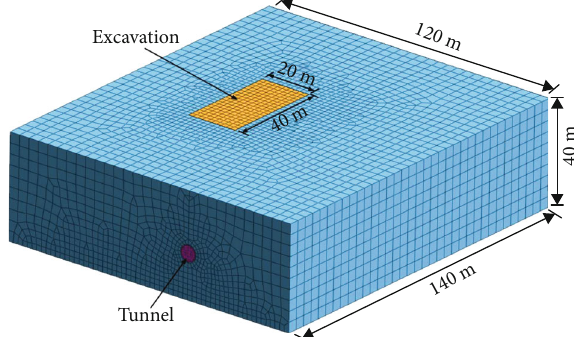
Figure 8: Meshing of numerical model for the HMLYRS